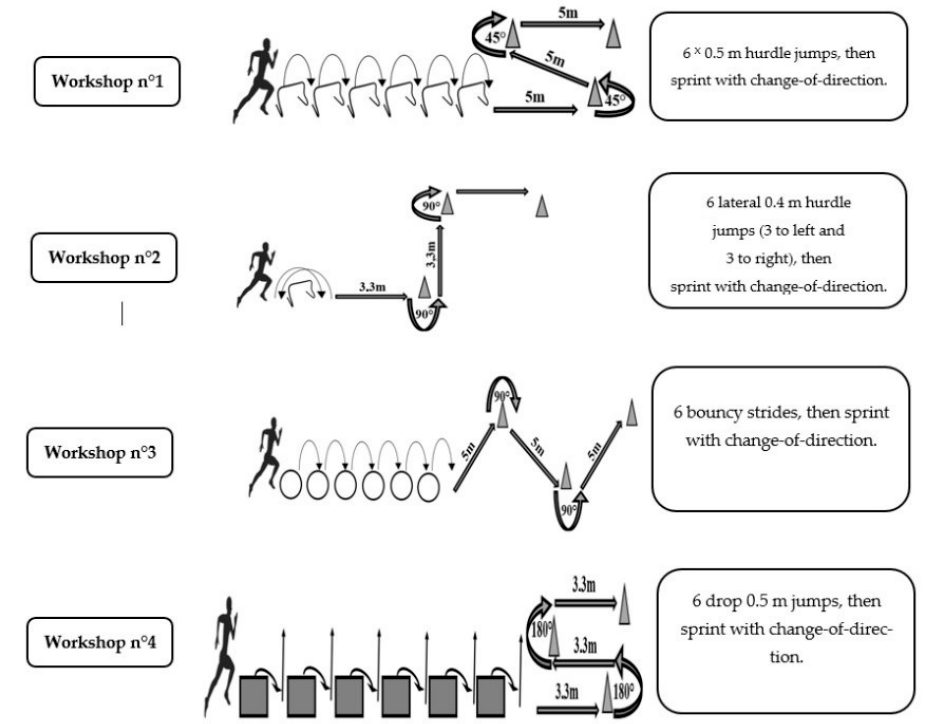
Figure 1. Exercise used in combined plyometric training program. Each workshop began with plyometric exercises (hurdle jumps, lateral hurdle jumps, bouncy strides, and drop jumps) and finished with a short change-of-direction sprint (Table 2). Table 2. Plyometric components introduced into the program of the experimental group.